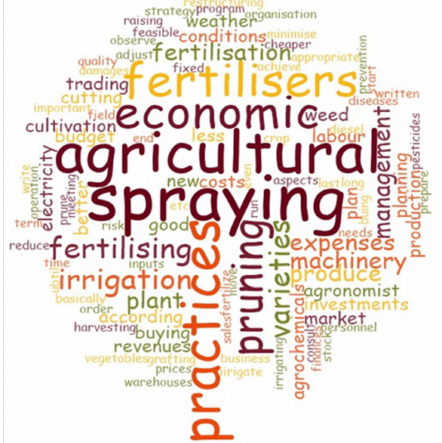
Figure 2. Planning process-word cloud. Taken from N-VIVO